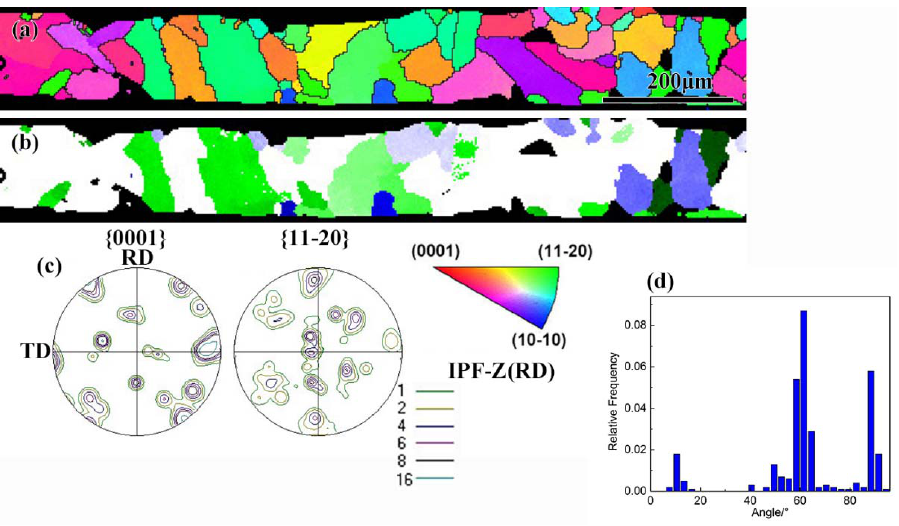
Figure 8. ( a ) Orientation maps; ( b ) texture component maps ({11–20}//RD is in green color); ( c ) pole figures; and ( d ) misorientation of 90% cold-rolled sample following annealing at 1000 ◦ C under Ar atmosphere and cooled with a cooling rate of 400 ◦